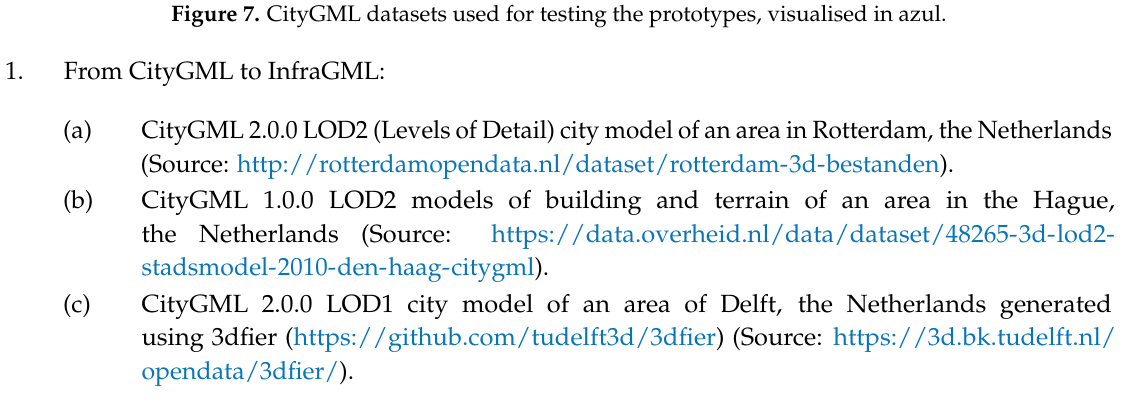
Figure 7. CityGML datasets used for testing the prototypes, visualised in